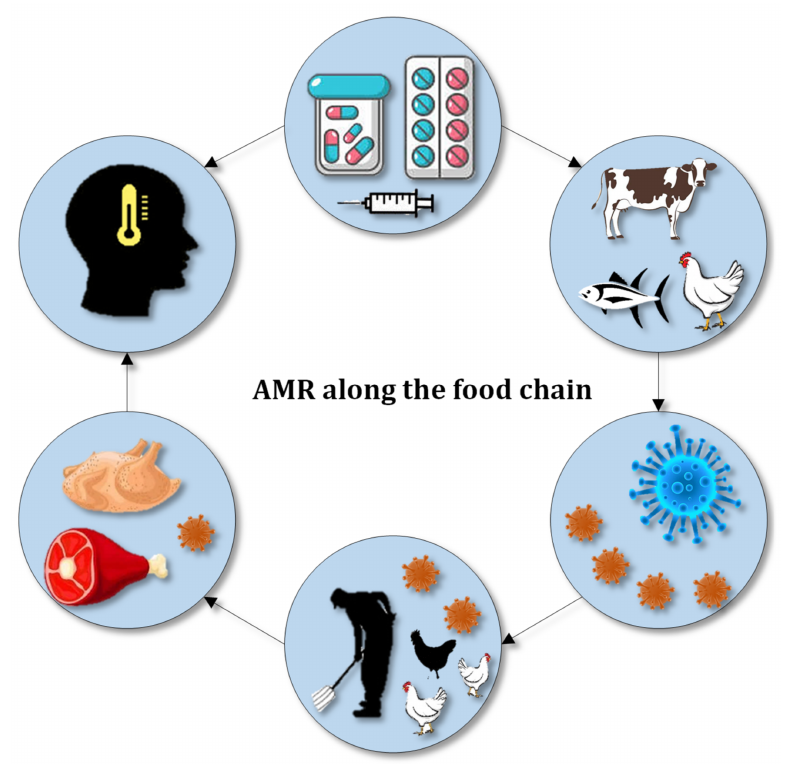
Figure 3. Transmission of AMR agents from soil to the human body through the food chain, adapted from WHO